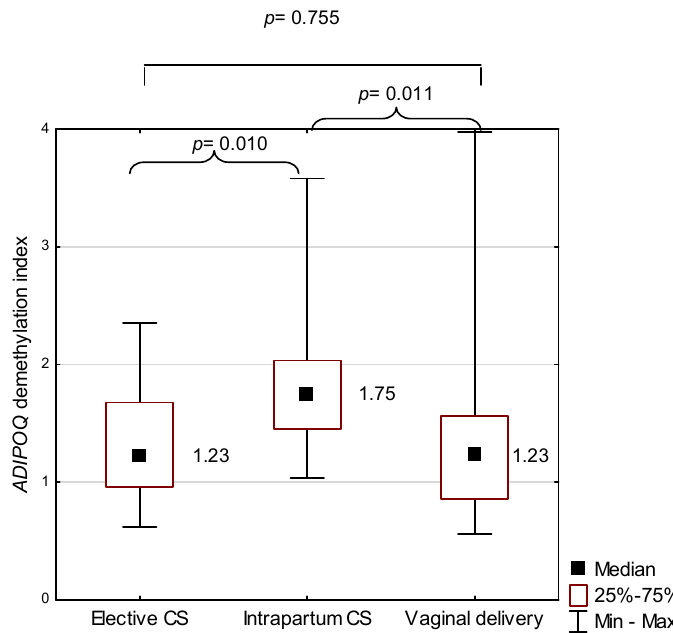
Figure 4. ADIPOQ demethylation index against the mode of birth; p represents results from the Mann–Whitney U test to compare ADIPOQ demethylation index between two modes of CS—cesarean section.